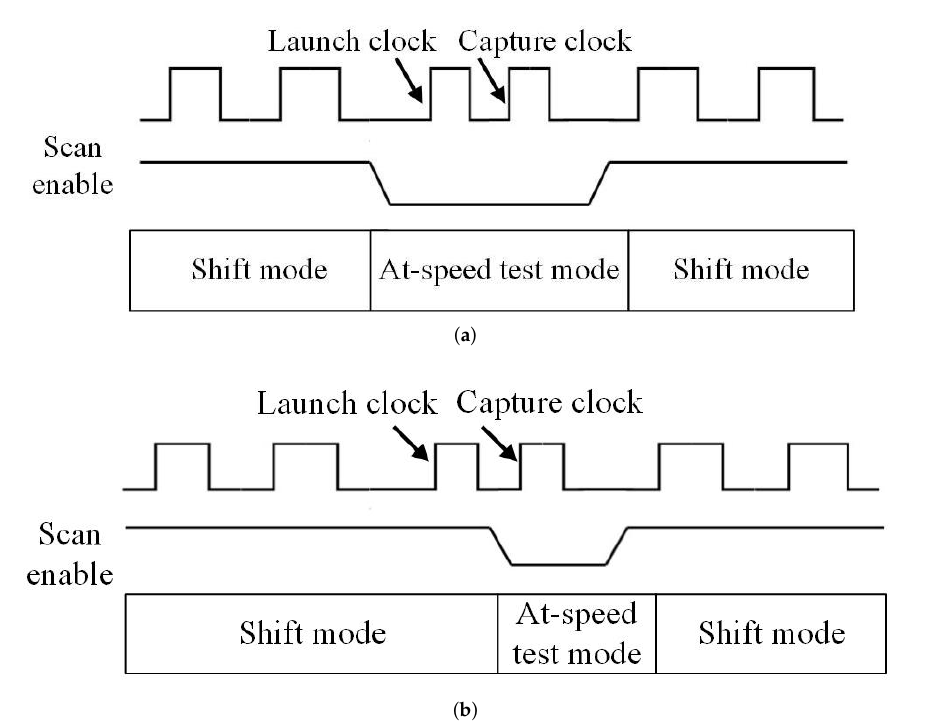
Figure 2. ( a ) Waveform for LOC based scheme for pattern generation; ( b ) Waveform for LOS based scheme for pattern generation.